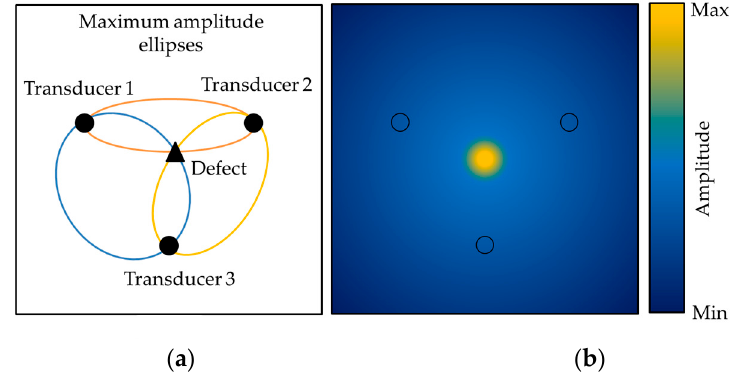
Figure 6. ( a ) Schematic of the effect caused by summing the ellipse generated by the baseline subtracted signals; ( b ) At a defect the ellipses are interfering constructively.